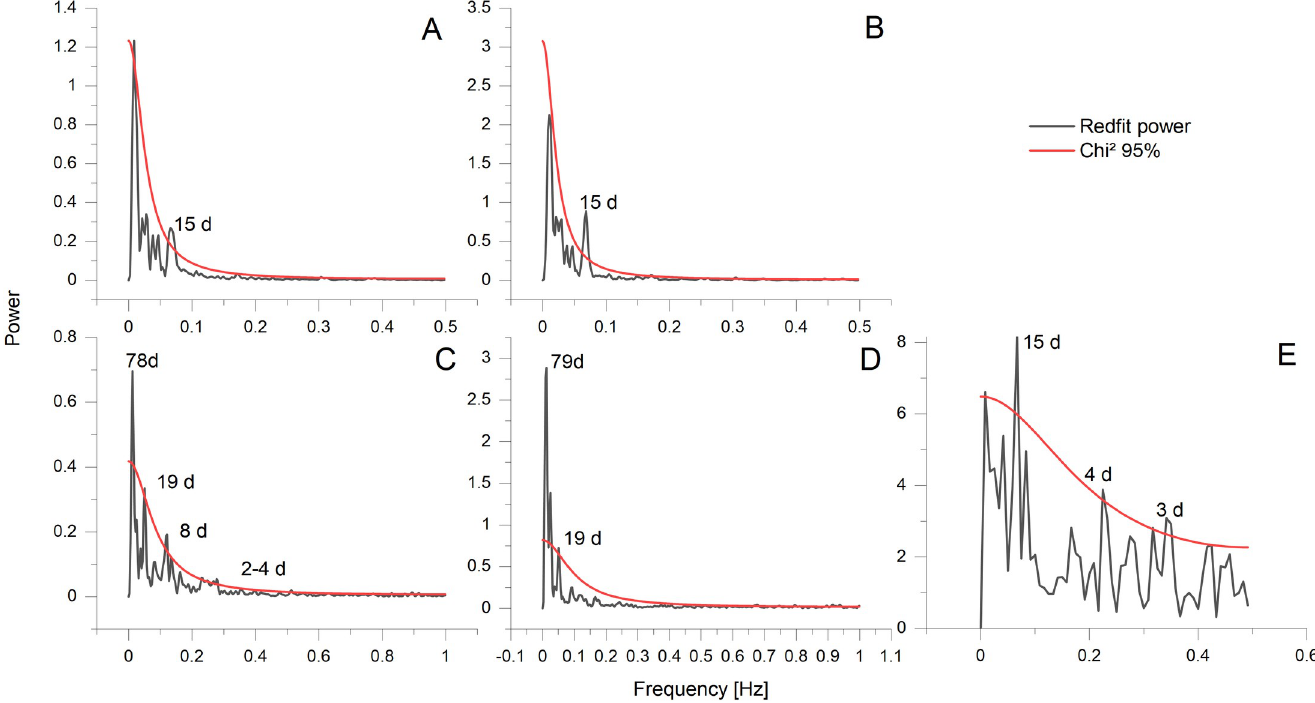
Fig 6. REDFIT spectral analysis of oceanographic data. Upper row: Temperature (A) and Salinity (B) at Nord-Leksa Reef. Lower row: Temperature (C), Salinity(D), and flow velocity (E) at Sula Reef.